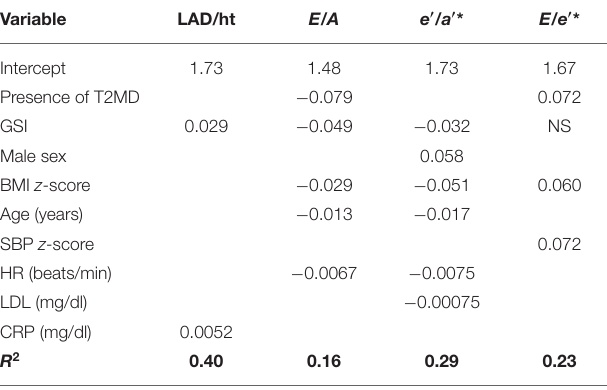
TABLE 3 | Independent determinants of diastolic function.